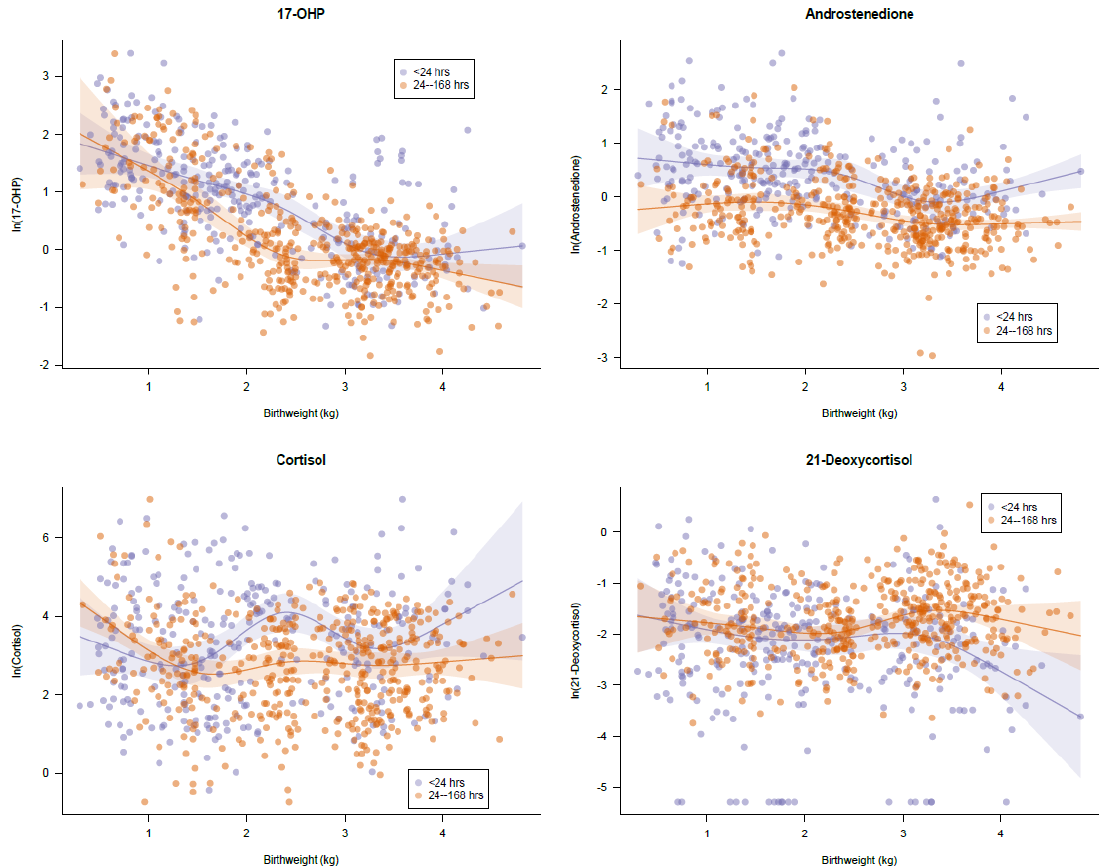
Figure 2. Normal distribution profiles. Figure 2 plots the log-transformed value for each steroid (17OHP, 4-A, F, 21) against the birth weight of the newborn. Dots in orange represent specimens collected prior to 24 h of life. Dots in blue represent specimens collected at 24 h of life or